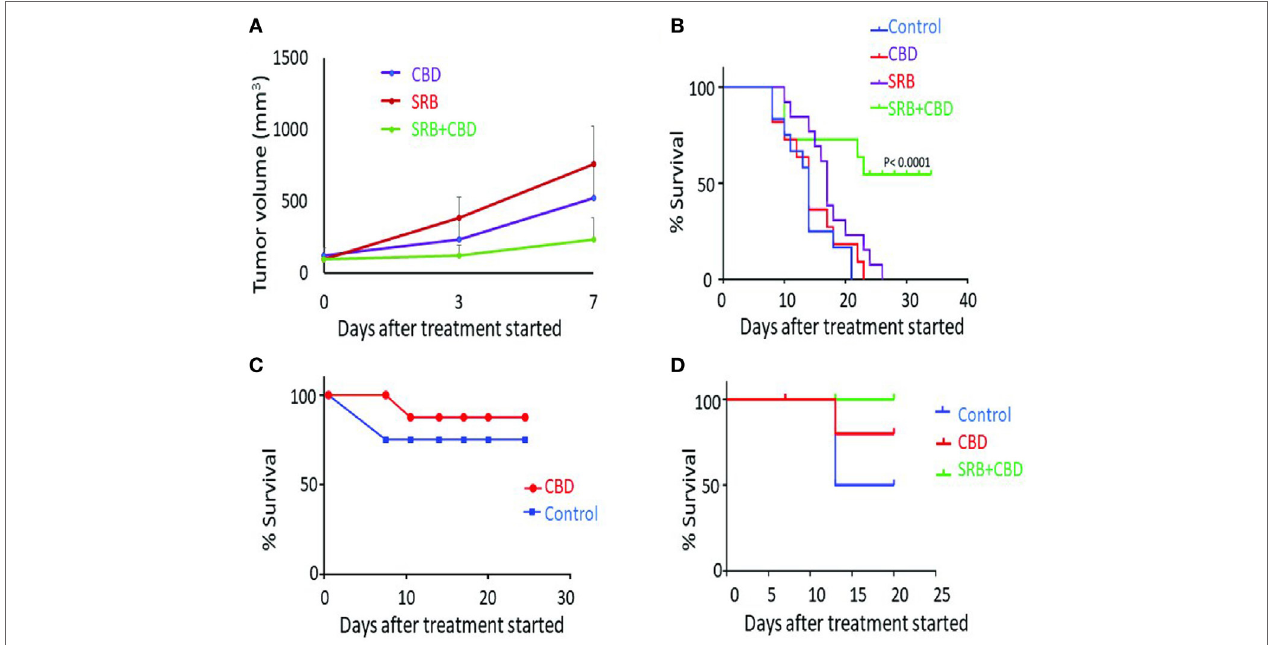
FigUre 4 | Antitumor effect of cannabinoid (CBD) and smart biomaterial (SRB)-CBD in vivo . (a) Lung tumor volume measurements highlight greater inhibition of tumor growth when using CBD-loaded SRBs compared to direct intratumoral administration (IT injection) and control cohorts: empty SRB. (B) Inhibition of lung tumor growth when using SRBs for sustained delivery of CBD, confirming higher killing effect of sustain release of CBD in the tumors. The Kaplan–Meier survival curve showing survival time (in days) for mice tumors treated with an empty SRB ( n = 11), direct CBD ( n = 13), CBD-loaded SRB ( n = 12), and control cohort ( n = 12). (c,D) A pilot study showing increased survival benefit of pancreatic tumor treated with (c) direct IT injection of CBD compared to control and (D) using SRBs for sustained delivery of